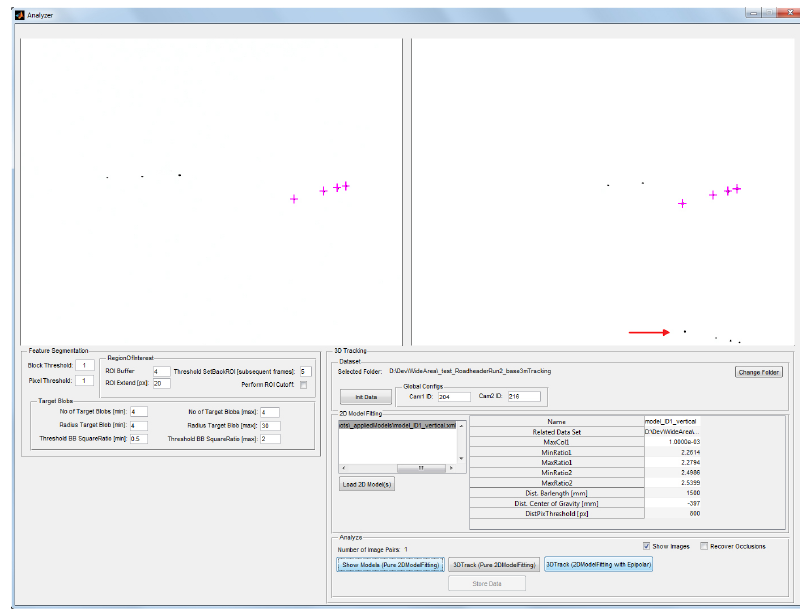
Figure 18. User interface of Controller to analyze data during calibration and